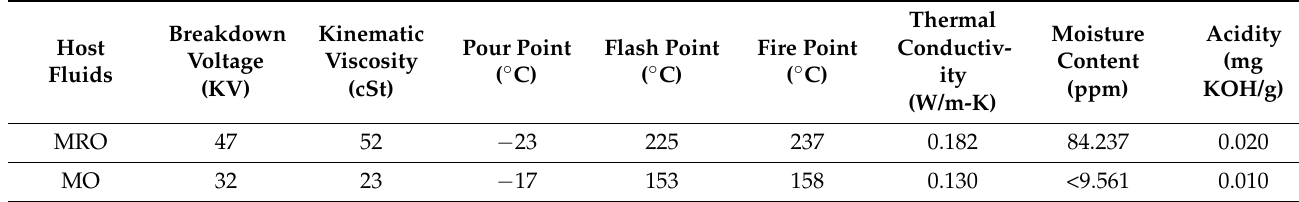
Table 1. Dielectric characteristics of host